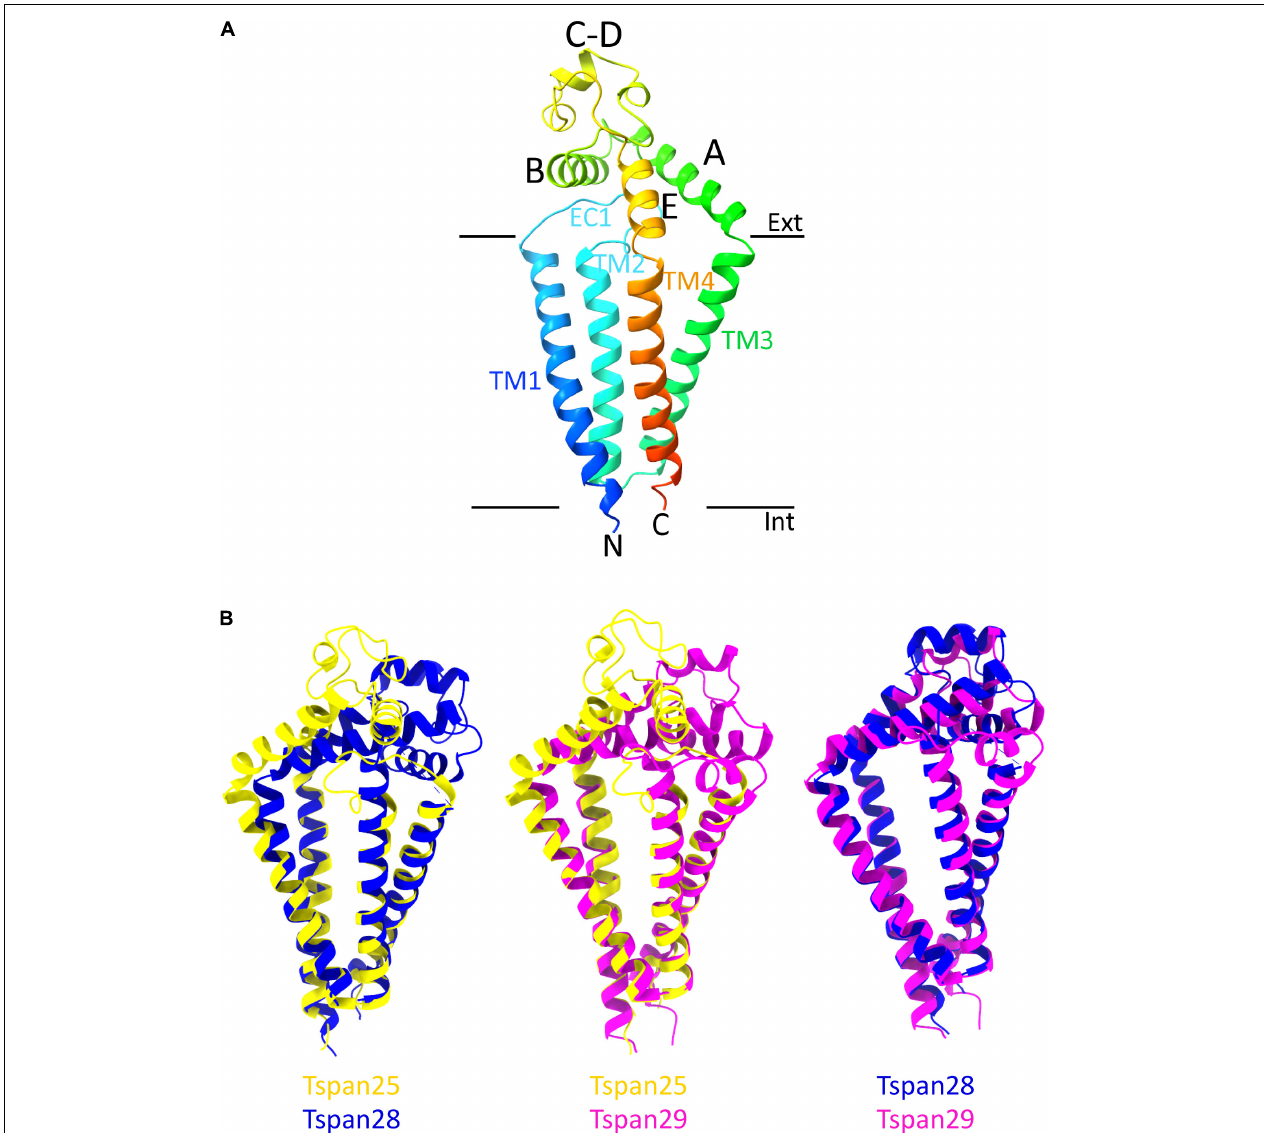
FIGURE 4 | Overall structure of a tetraspanin (A) . Helices A–E are indicated in the EC2 domain between TM3 and TM4. Helices A, B, and E represent conserved regions, while helices C–D are variable among tetraspanins. Superposition of all previously resolved structures of tetraspanins (B) . Shown is the overlay of Tspan25 (pdb model 6WVG in yellow) with Tspan28 (pdb model 5TCX in blue) and of Tspan25 (yellow) with Tspan29 (pdb model 6K4J in magenta) as well as of Tspan28 (blue) with Tspan29